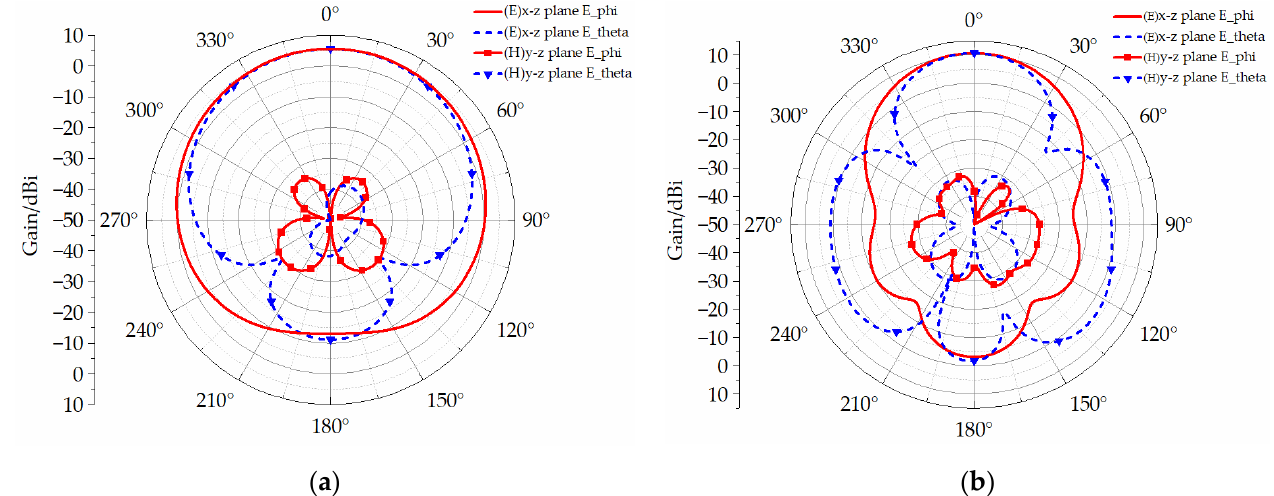
Figure 4. Simulated radiation patterns of the proposed DRA: ( a ) 2.45 GHz; ( b ) 5.8 GHz.